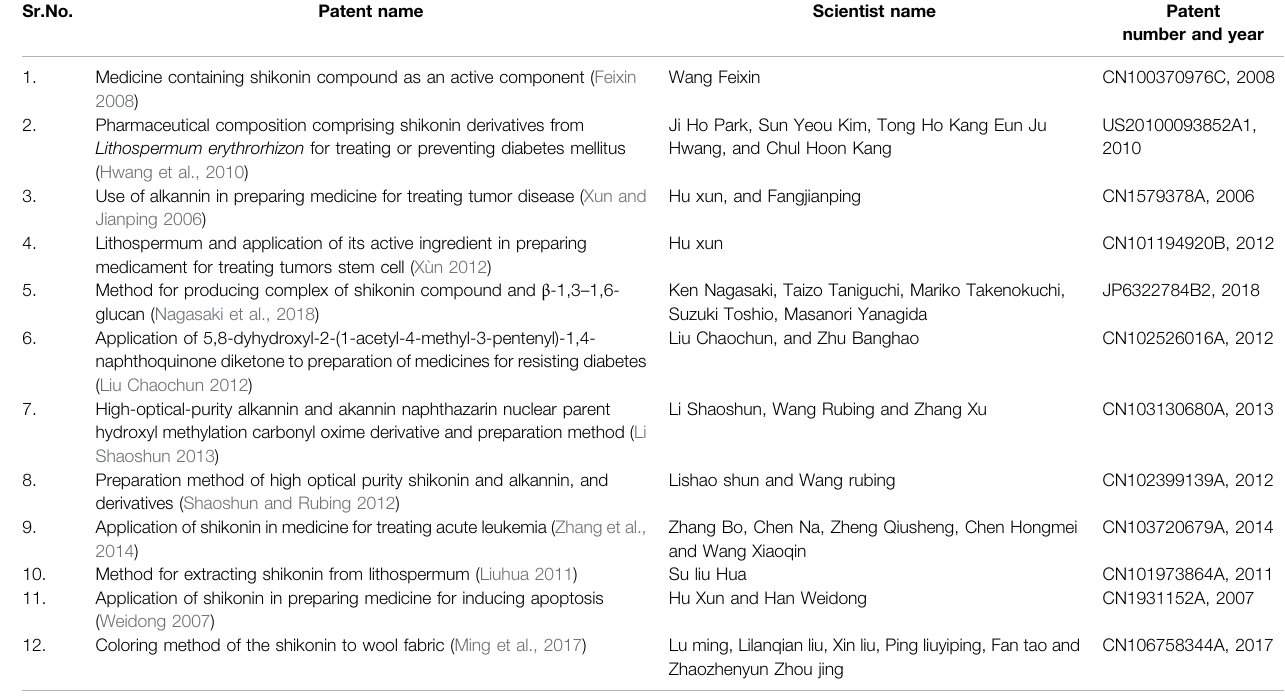
TABLE 8 | Patents fi led on shikonin and its derivatives. Sr.No.